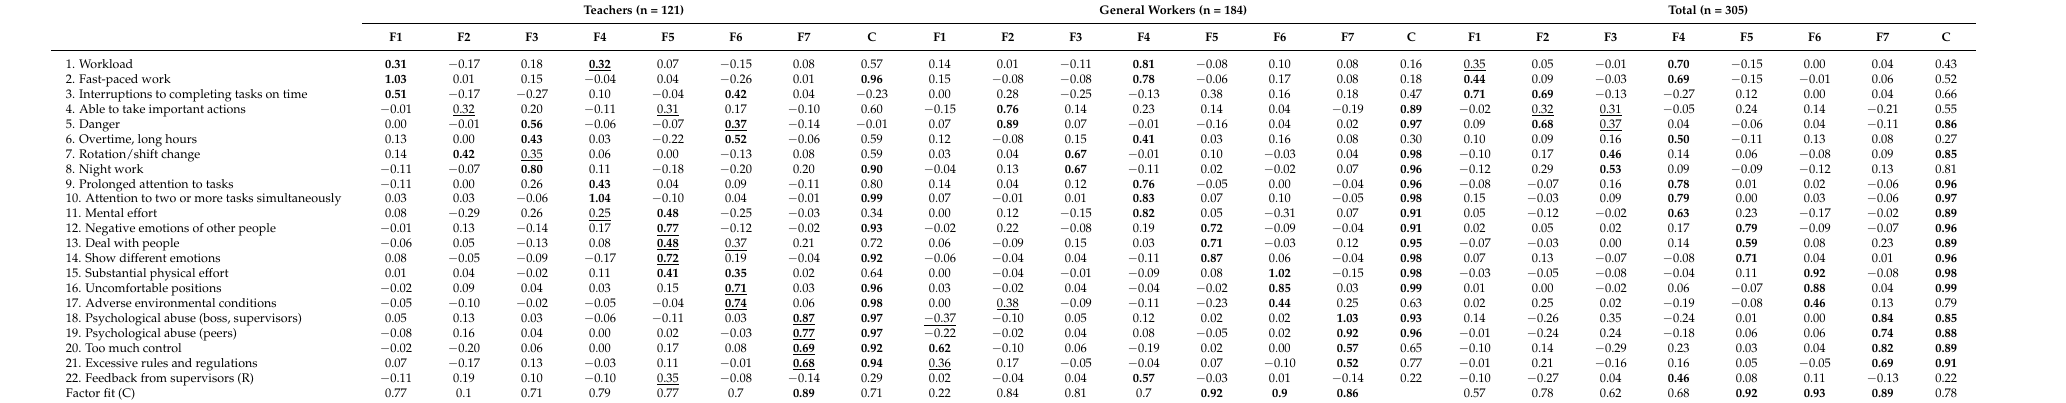
Table 4. Psychosocial risk factors: Semiconfirmatory factor analysis, first